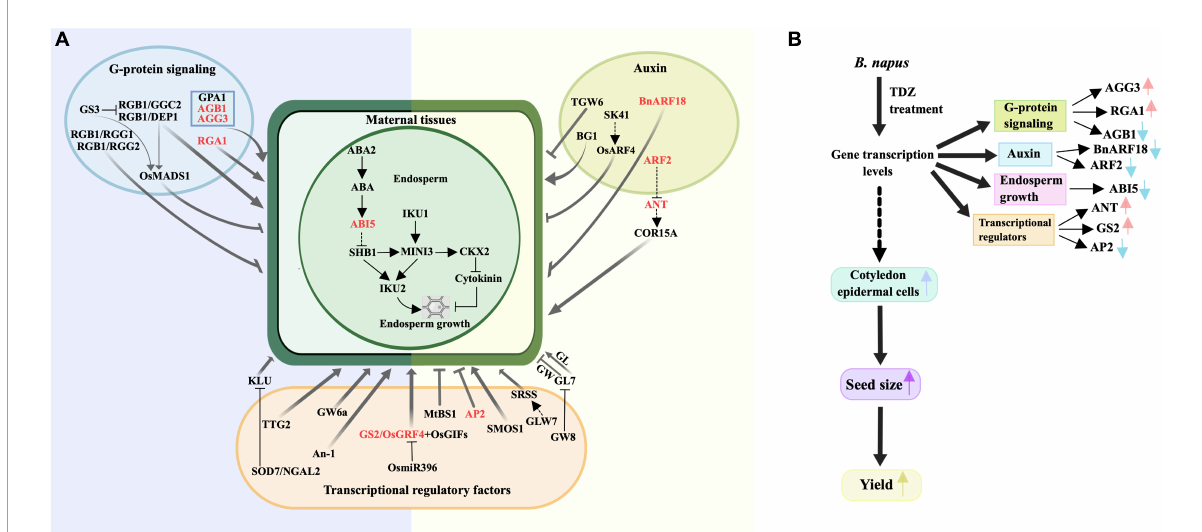
FIGURE7 Diagram of signaling pathways associated with seed size (A) and a schematic diagram of a simulation mechanism explaining the regulation of seed size by TDZ (B) . (A) The image showed the genes related to the seed size in four different signaling pathways in Arabidopsis , rice and other species, where the red text represented the genes studied in this paper in B. napus , and the dashed lines indicated unclear genetic relationships (Li et al., 2019). ABA, abscisic acid; GL, grain length; GW, grain width. (B) TDZ treatment may initially affect changes in gene expression levels the yield of related to the seed size, resulting in larger cotyledon epidermal cells, increased seed size, and ultimately a substantial increase in B. napus